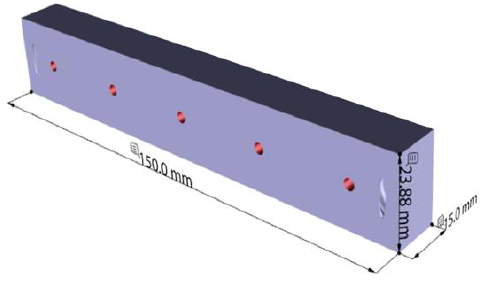
Figure 3. Nominal star tracker camera bracket.